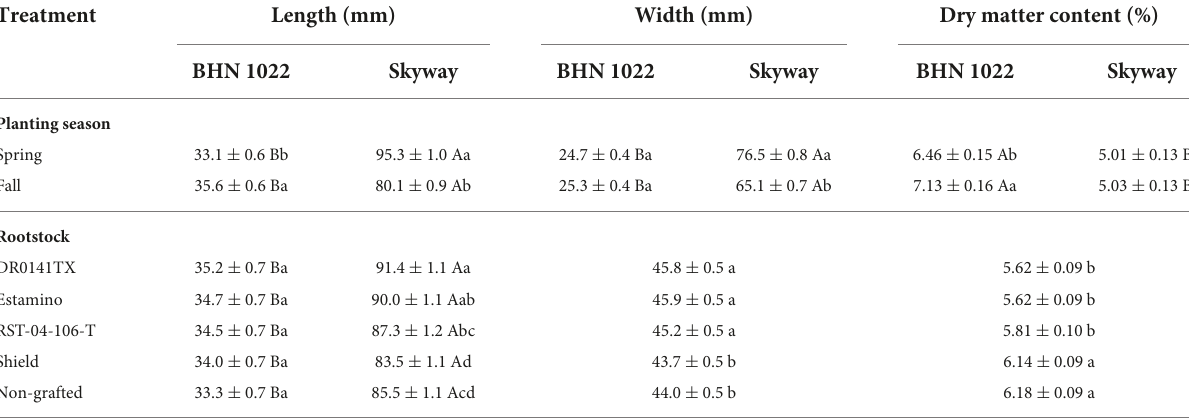
TABLE 4 Fruit length, width, and dry matter content of fruit from grafted beefsteak tomato ‘Skyway’ and grape tomato ‘BHN 1022’ in Spring and Fall plantings. Treatment